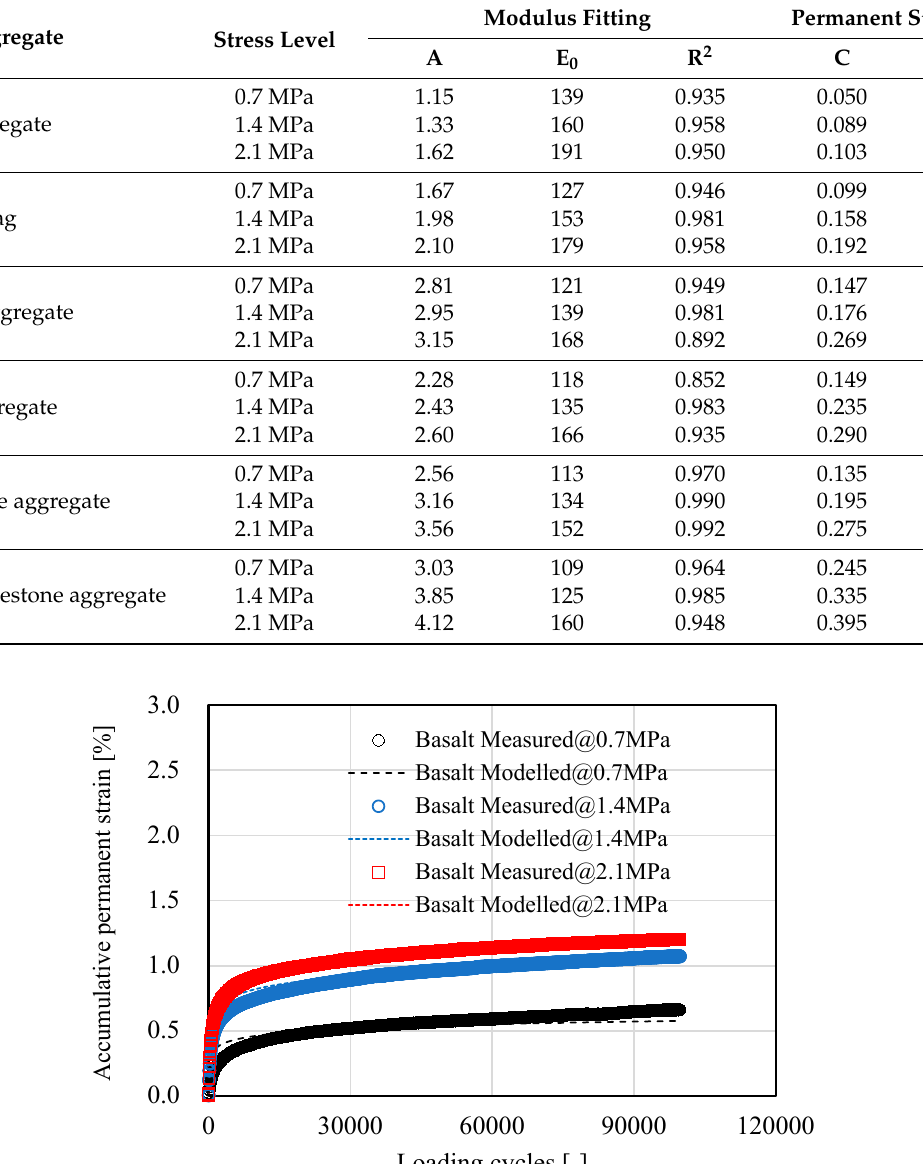
Figure 8. Development of accumulative permanent strain of basalt aggregate under cyclic loading.